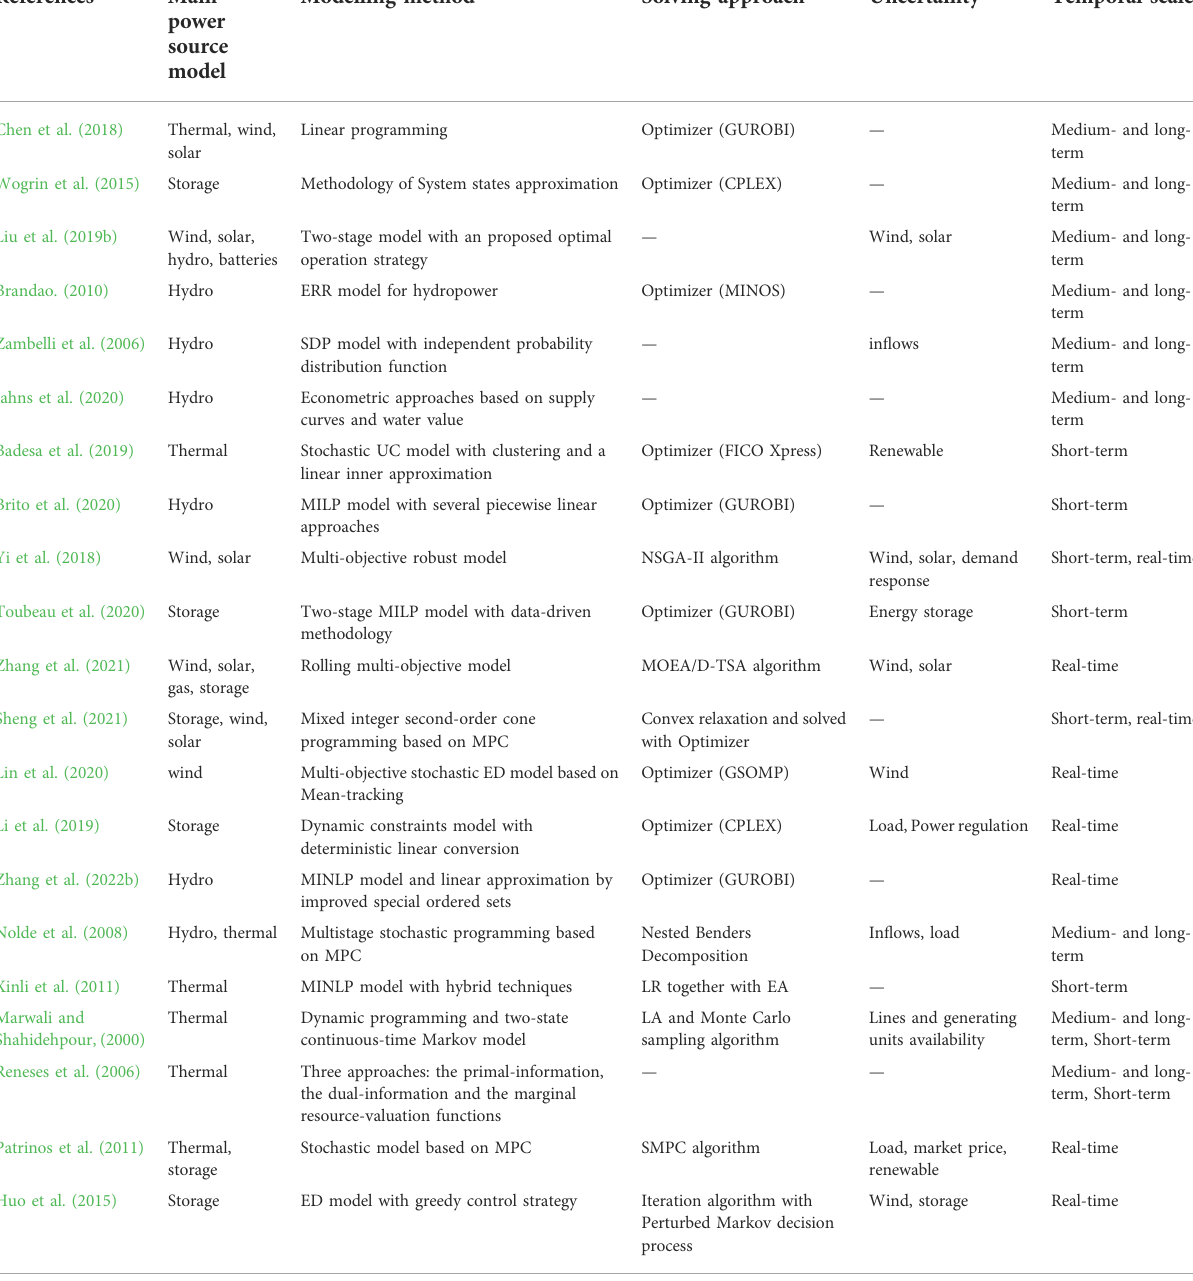
TABLE 2 Comparison of typical cited